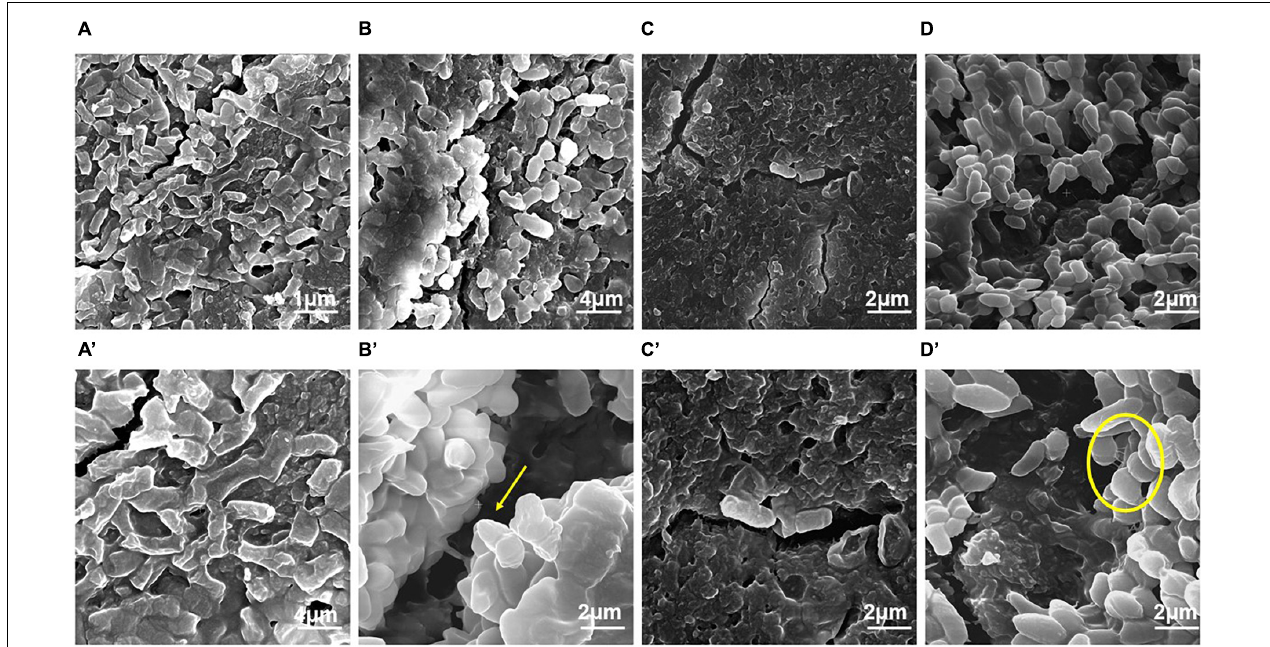
FIGURE 3 | Field emission-scanning electron micrographs of the biofilm by E. cloacae SBP-8 on latex catheter at 37 ◦ C observed at different time intervals (24–96 h). (A) Image of bacterial population in biofilm at 24 h of growth (magnification: 20,000 × ), (B) bacterial cells engrained at 48 h (magnification: 20,000 × ), (C) biofilm at 72 h (magnification: 40,000 × ), and (D) bacterial cells in biofilms at 96 h (magnification: 40,000 × ). Figures A’–D’ represent the magnified images of biofilm observed at 24, 48, 72, and 96 h, respectively (magnification: 40,000 × ). The encircled areas in Figures A’–D’ show the presence of EPS throughout the period of 24 to 96 h.